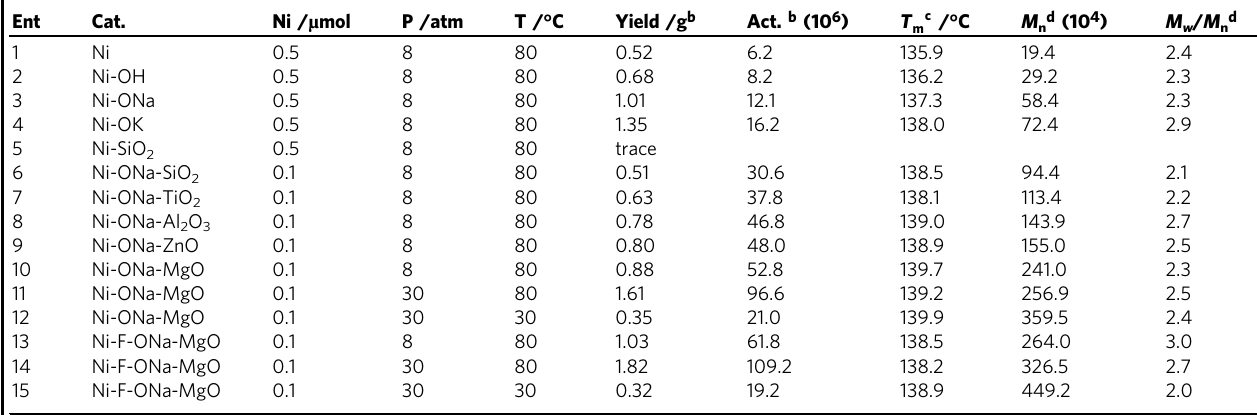
a Conditions: The same metal loading (20 µ mol/g) was used for all solid supports (10 µ mol/g loading for Ni-SiO 2 ); 5mL n -heptane; time = 10min. b Polymer yield and activity values are average of at least two runs. Activity = 10 6 gmol − 1 h − 1 .